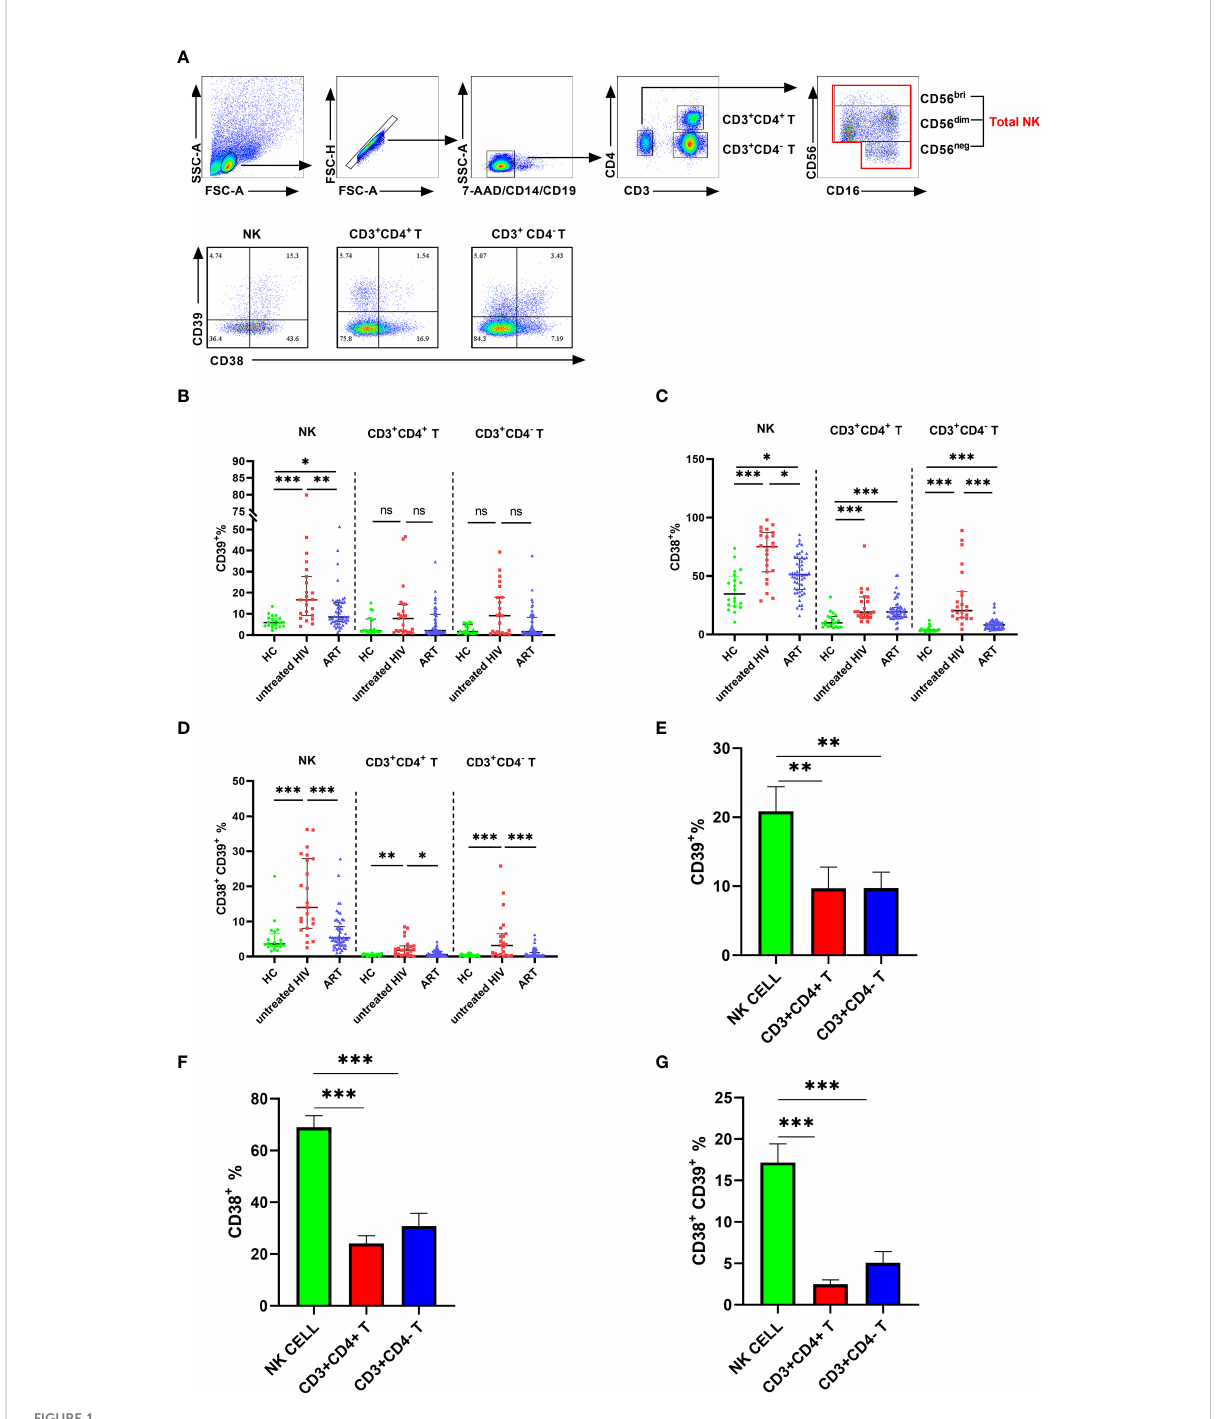
FIGURE 1 The expression of CD38 and CD39 on NK, CD3+CD4- T and CD3+CD4- T cells in HC, untreated HIV, and ART groups. (A) Gating strategy from fl ow cytometry analysis and the representative dot plots showing the expression of CD38 and CD39 on NK, CD3 + CD4 + T cells, and CD3 + CD4 - T cells. (B) Comparison of the expression of CD39 on NK, CD3 + CD4 + T, and CD3 + CD4 - T cells in HC, untreated HIV, and ART groups. (C) Comparison of the expression of CD38 on NK, CD3 + CD4 + T and CD3 + CD4 - T cells in HC, untreated HIV, and ART groups. (D) Comparison of the co-expression of CD38 and CD39 on NK, CD3 + CD4 + T, and CD3 + CD4 - T cells in HC, untreated HIV and ART groups. (E) Comparison of the expression of CD39 on NK, CD3 + CD4 + T, and CD3 + CD4 - T cells in HIV. (F) Comparison of the expression of CD38 on NK, CD3 + CD4 + T, and CD3 + CD4 - T cells in HIV. (G) Comparison of the co-expression of CD38 and CD39 on NK, CD3 + CD4 + T, and CD3 + CD4 - T cells in HIV. The Kruskal – Wallis test was used to compare the three groups. *p < 0.05, **p < 0.01, ***p < 0.001, ns: no signi fi